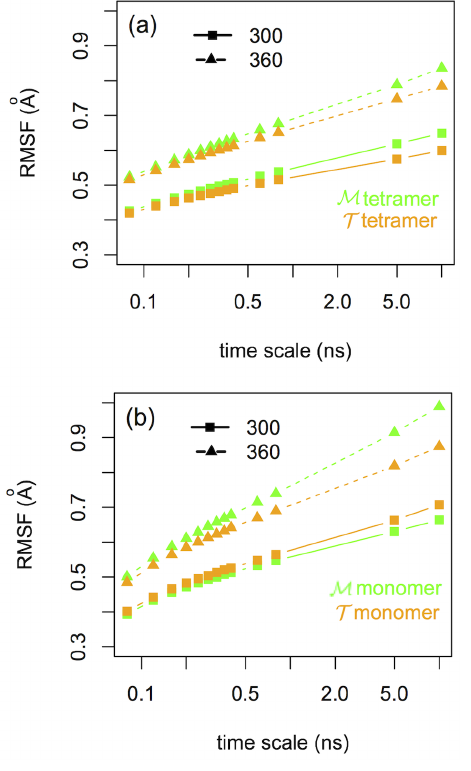
Figure 2. Flexibility at different time-scales. Average RMSF for M and T (a) tetramers and (b) monomers for both 300 K and 360